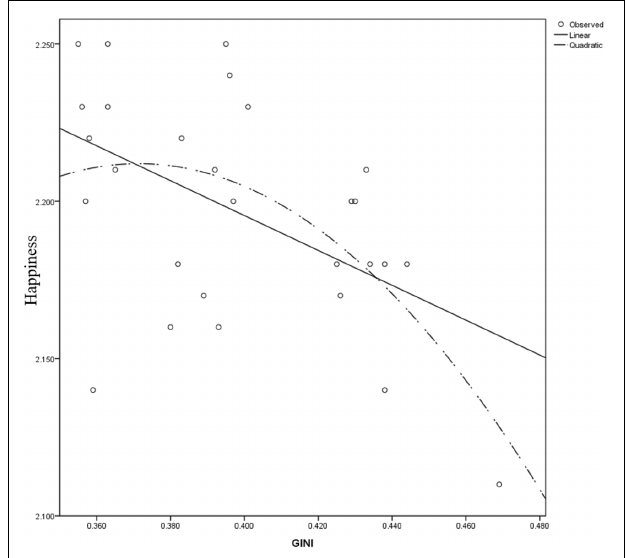
FIGURE 1 | Gini-happiness curve for the United